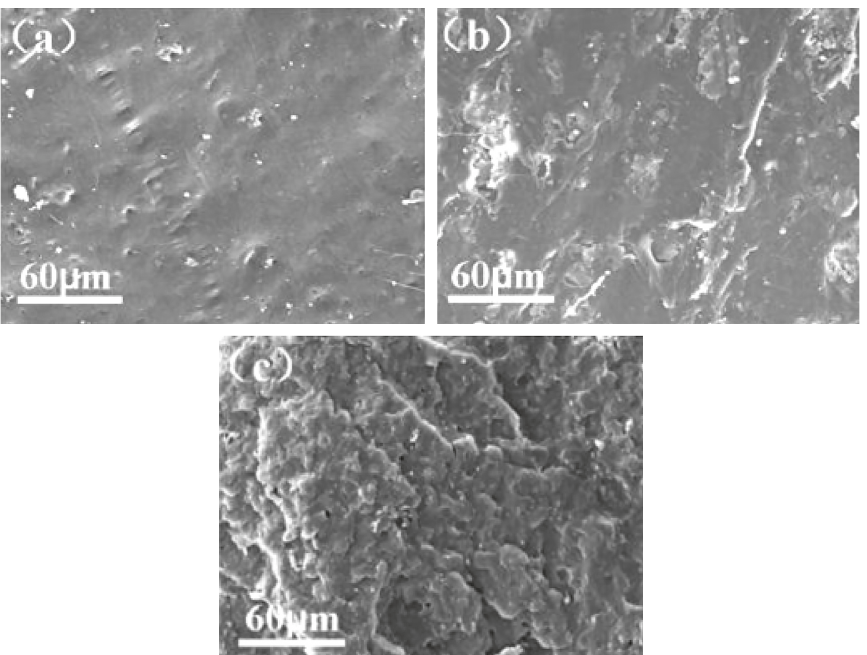
Figure 5: SEM ( 500) of (a) PP/PER, (b) PP/PEPA, and (c) ×